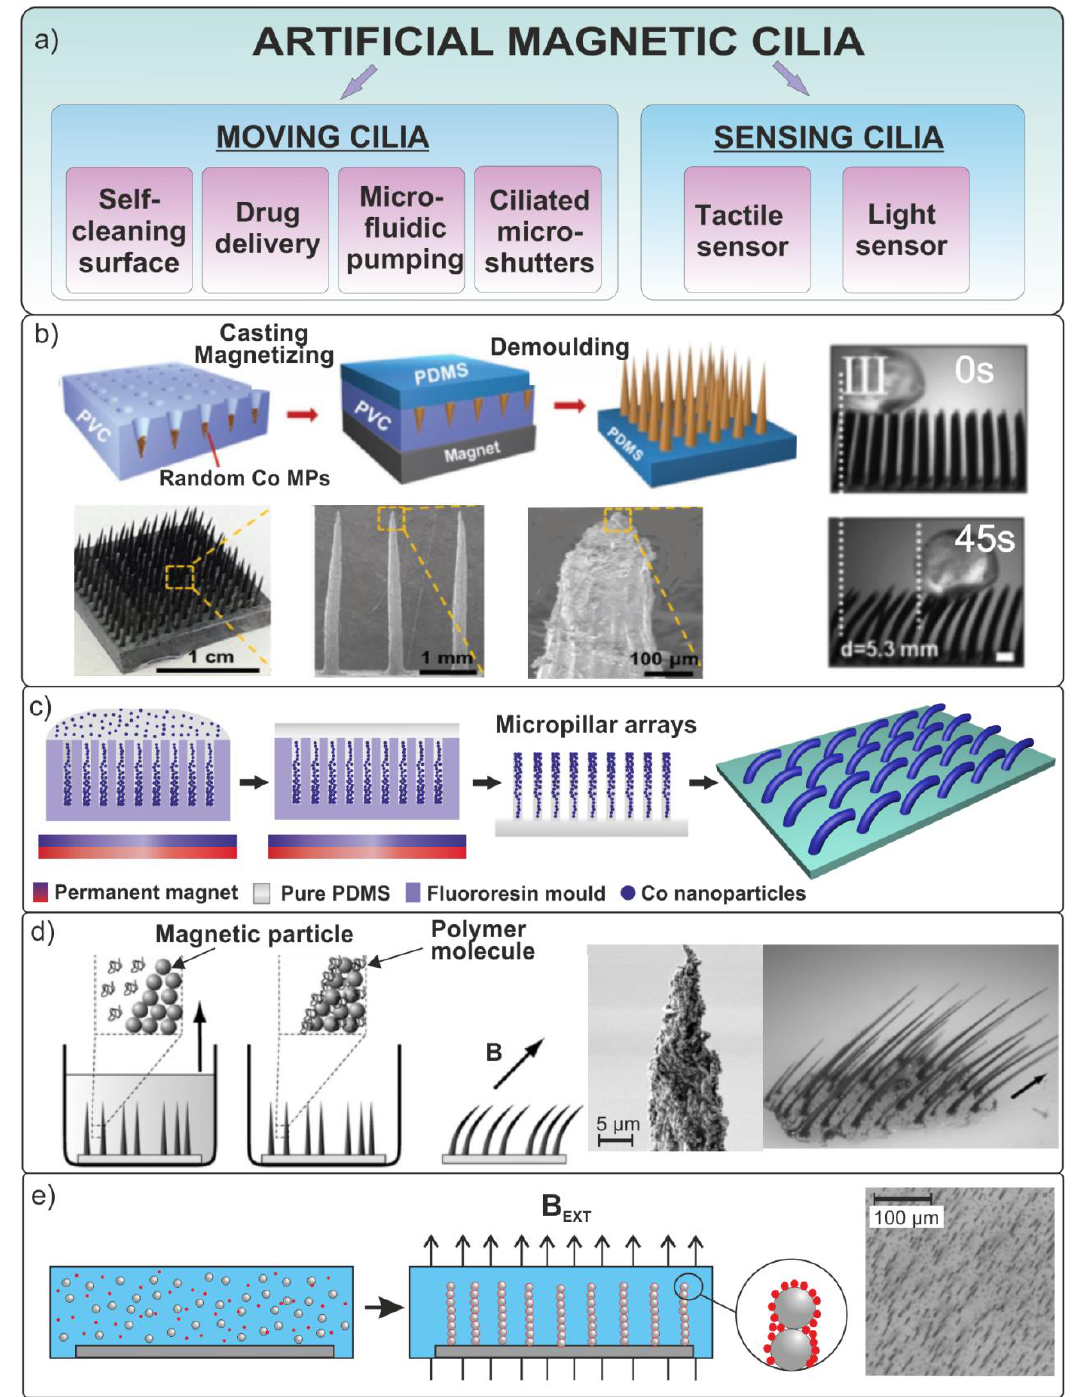
Figure 14. ( a ) Function of biomimetic magnetic cilia. ( b ) Fabrication procedure of magnetically flexible conical arrays. Observation of the movement of a microsphere effected by an array of magnetic cilia in an external magnetic field of B = 0.7 T [151]. ( c ) Schematic representation of the formation of magnetic epithelial cilia. ( d , e ) Self-assembly of magnetic nanoparticles in a magnetic field gradient inside a polymer matrix, and optical photos of fabricated cilia under applied external magnetic field [153,154]. Copyright 2010, American Chemical Society. Reproduced from [153]. Copyright 2012, American Chemical Society. Reproduced from [154]. CC BY 3.0.